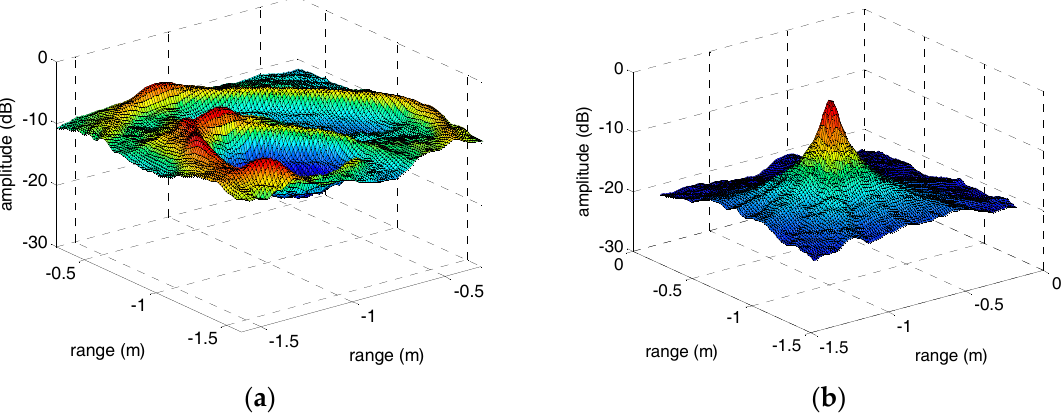
Figure 11. The IRT results of the warhead model’s HRRP sequences through adjacent correlation correction and our method. ( a ) The adjacent correlation correction. ( b ) The method in this paper.